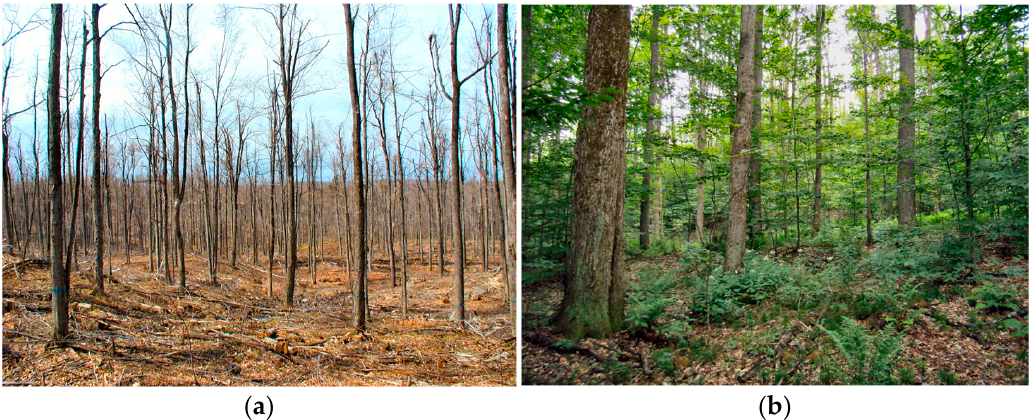
Figure 2. Residual stand at Taylor Creek ( a ) after rehabilitation cutting that reduced stocking to approximately 40–45% relative density of the best upper-canopy trees at 7.6–10.7 m spacing, and showing residual conditions at 33 years after crown thinning to 61% relative density at Ranger School ( b ).